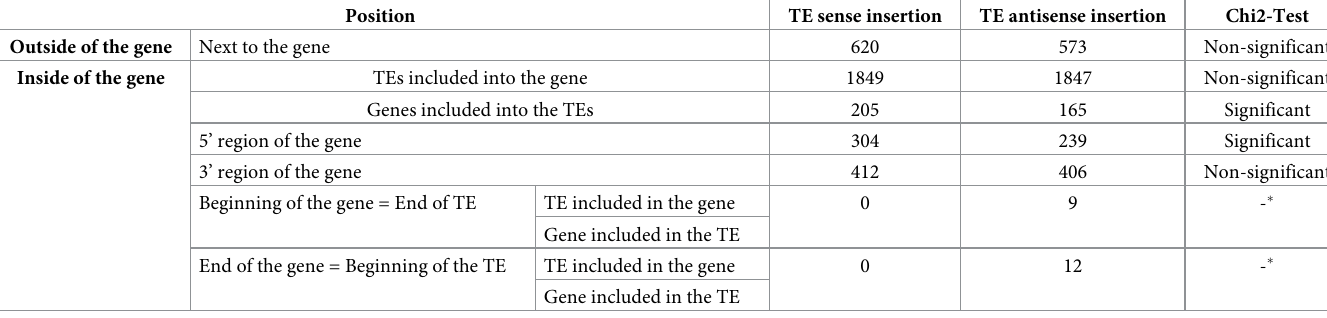
Table 2. Representation of the cases and numbers of TE among Mayetiola destructor genes.